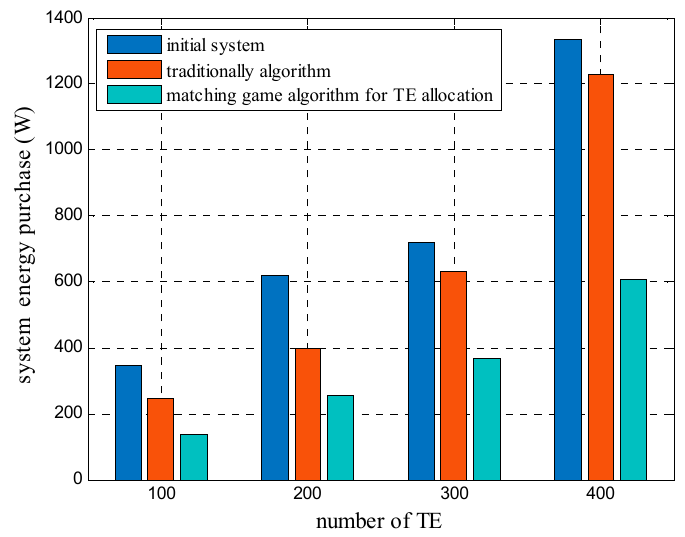
ff erent numbers of terminal equipment.